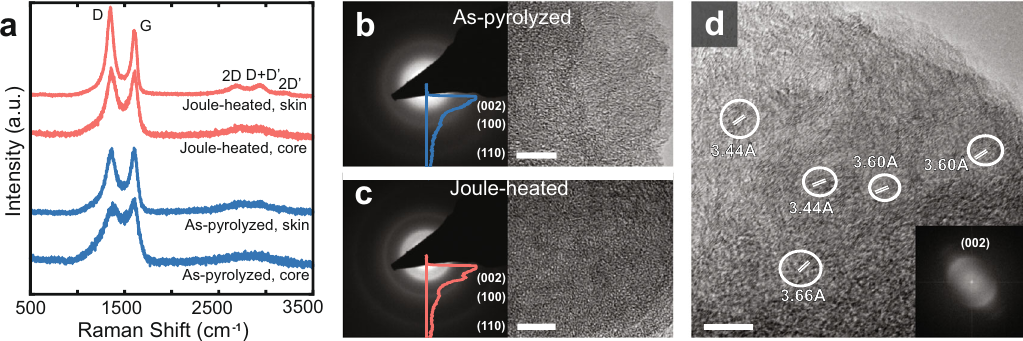
Fig. 3 Characterization of constituent carbon by Raman spectroscopy and TEM. a Raman spectra collected with an incident wavelength λ = 514 nm from the skin and the inner core of the beams reveal that the as-pyrolyzed samples are mainly constituted of amorphous carbon, while Joule heating increased the degree of sp 2 -hybridization and introduced a defect-rich nanographitic skin. Representative diffraction patterns and TEM images of as-pyrolyzed ( b ) and Joule-heated ( c ) carbon. Inset spectra with diffraction patterns indicate the grayscale intensity of diffraction rings for each crystallographic direction. d A high-resolution TEM (HRTEM) image of Joule-heated carbon containing nanocrystalline graphite and its FFT pattern. Circles highlight the nanocrystals that are ~10 nm long, with graphene sheets spaced at ~3.4 – 3.7 Å. The inset reports the intensity of the FFT diffraction ring for graphite (002), which increases along the direction where graphene sheets are stacked. Scale bars are 10